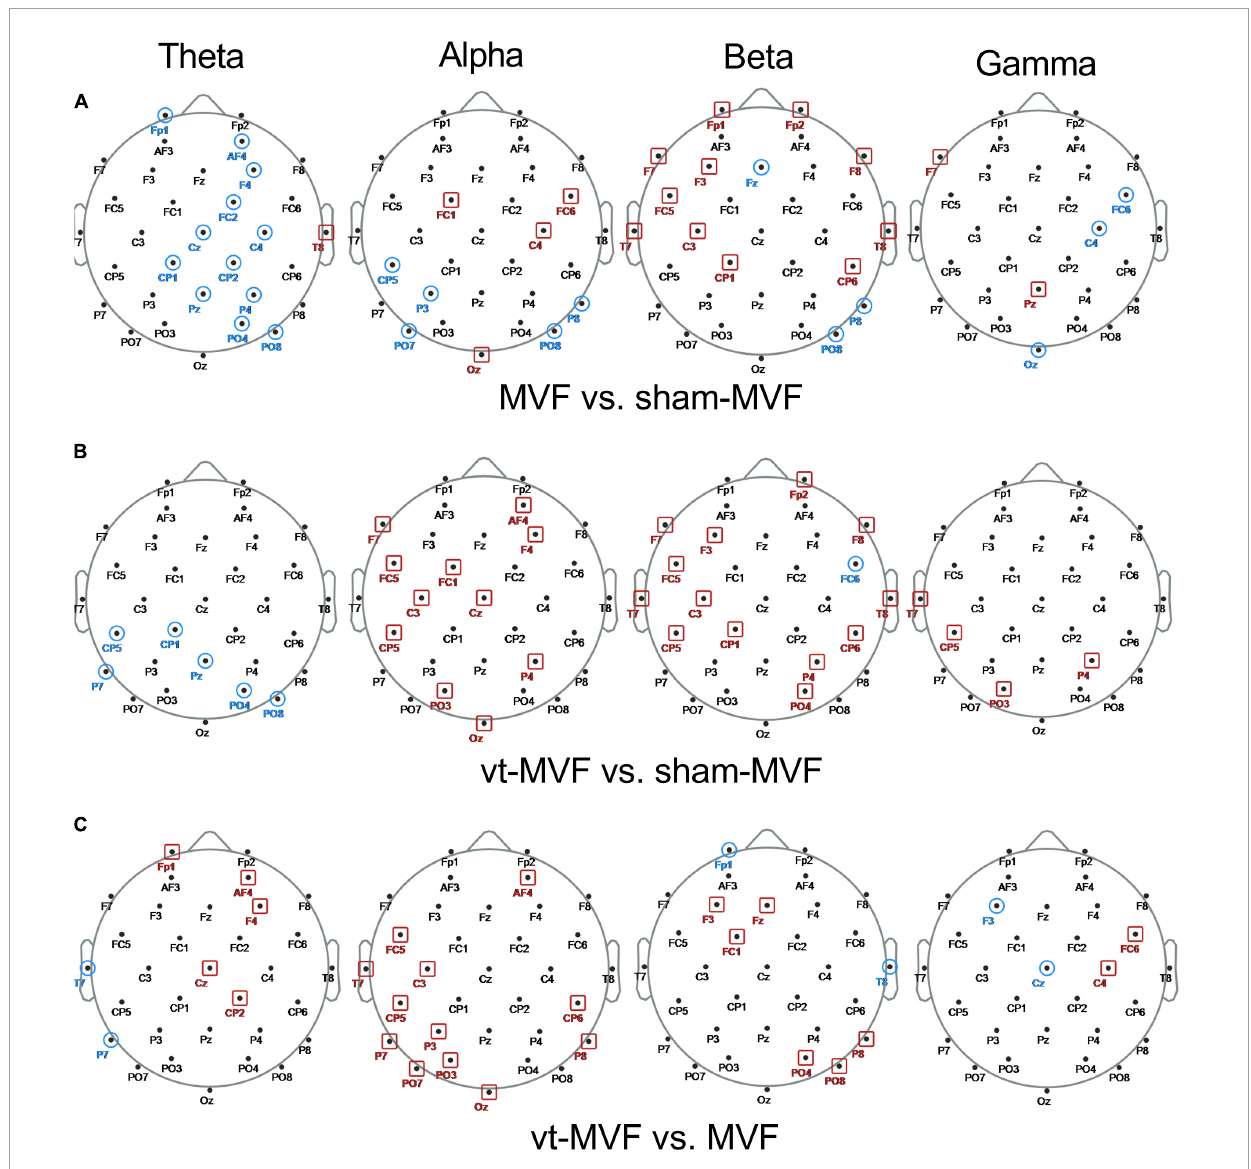
FIGURE4 Scalp topological differences between (A) mirror visual feedback (MVF) and sham-MVF, (B) vt-MVF and sham-MVF, and (C) vt-MVF and MVF experimental conditions in different frequency bands (from left to right in each row corresponding to theta, alpha, beta, and gamma frequency band, respectively). Taking the condition pair MVF vs. sham-MVF as an example, the node marked with a red square denoted that the node degree of MVF on this location was significantly larger ( p < 0.05) than that of sham-MVF, while the node marked with a blue circle denoted the opposite case.